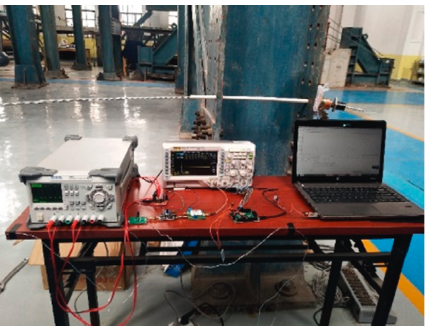
Figure 8: Field experimental diagram of aluminum/steel